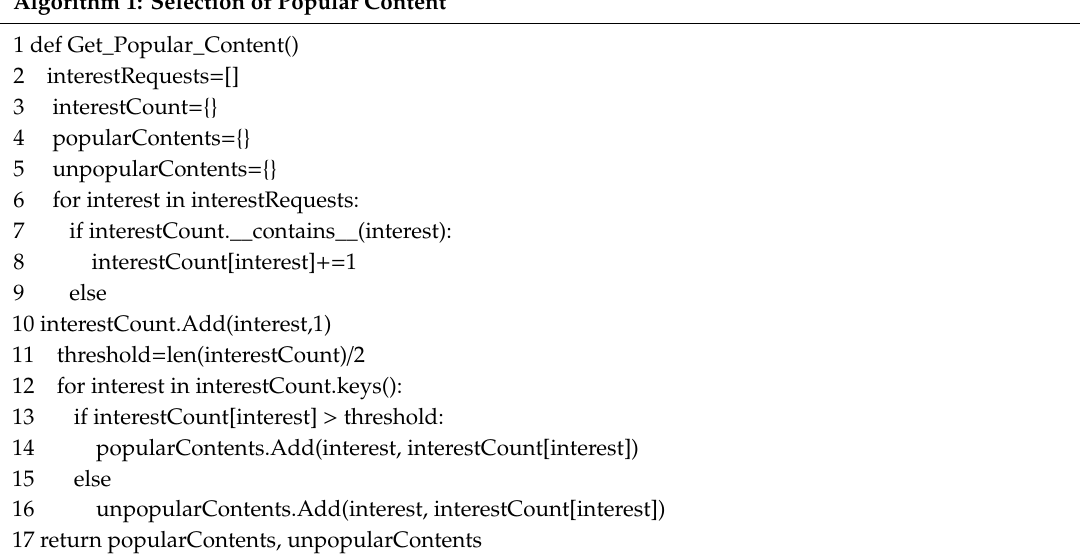
Figure 5. Selection of Popular Content. Algorithm 1: Selection of Popular Content